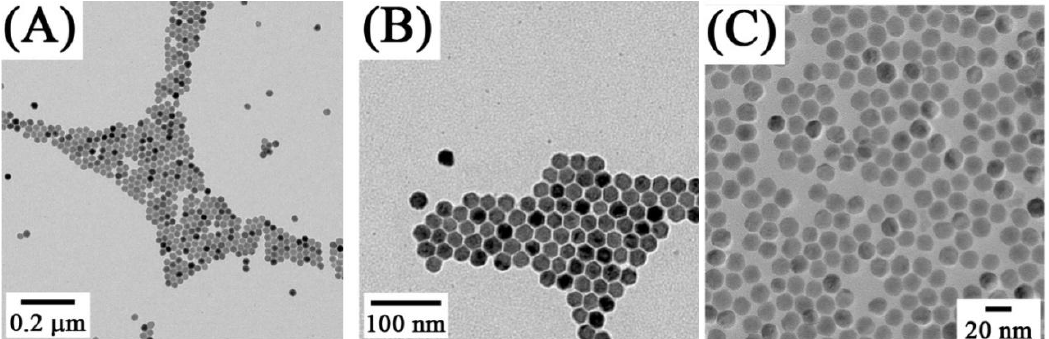
Figure 5. ( A , B ) Low-resolution TEM images of NaYF uniformity of the particles [27] and ( C ) TEM image of oleic acid-capped NaGdF /Ho 3+ obtained from thermal decomposition ([91], reproduced by permission of The American Chemical